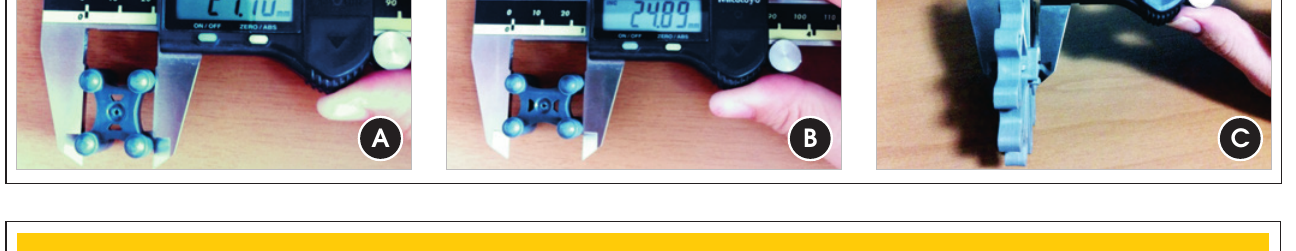
Table 1 – Dimensional parameters for the minimum design requirements